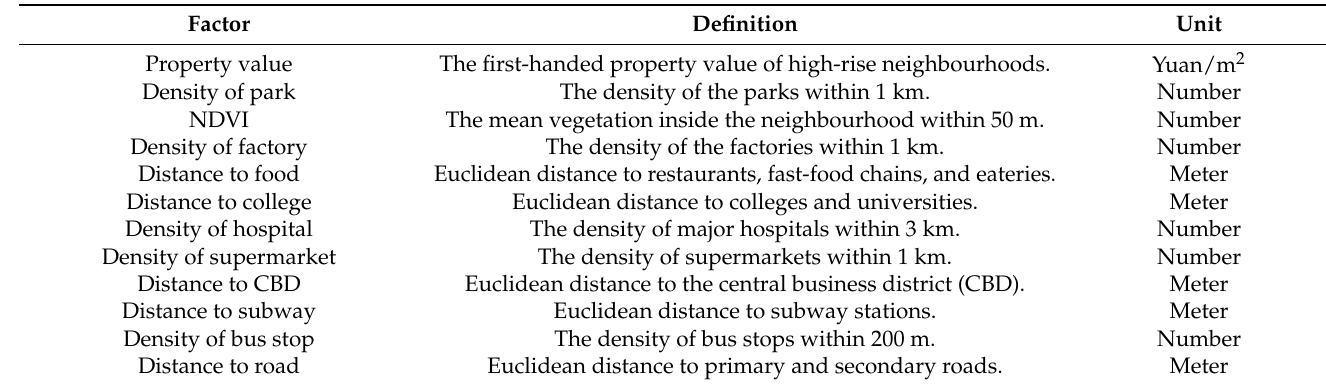
Table 2. Overview of 2D factors.